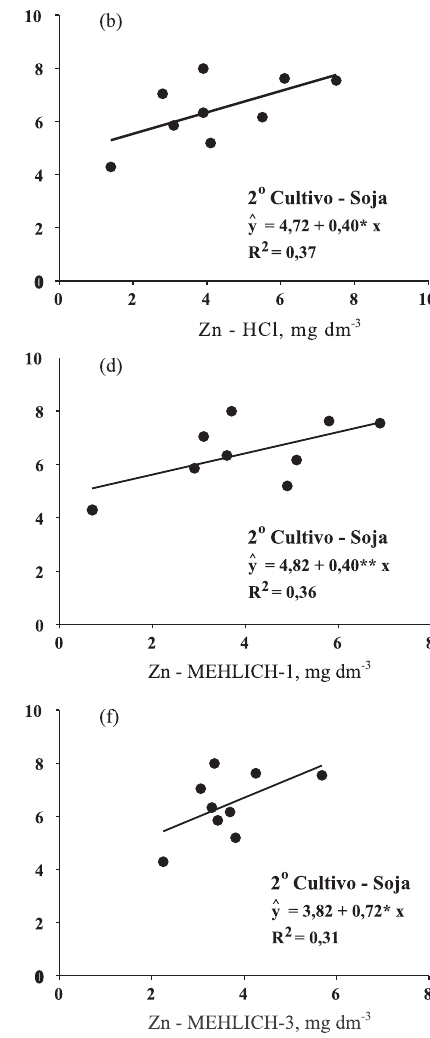
Figura 4. Relação entre os teores de zinco extraídos pelas soluções de HCl, Mehlich-1 e Mehlich-3, respectivamente, e a quantidade acumulada pelas plantas de milho [(a), (c) e (e)], no primeiro cultivo, e de soja [(b), (d) e (f)], no segundo